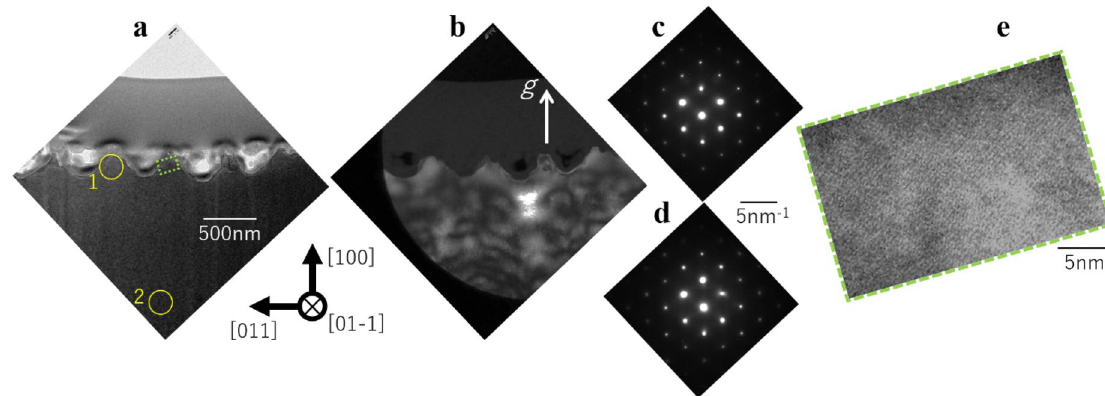
Figure 3. TEM images of the LIPSS induced by Ti:Sapphire laser. ( a ) Bright-field TEM image, ( b ) dark-field image, ( c ) diffraction pattern of area 1, ( d) diffraction pattern of area 2, ( e ) high-resolution image of the square- marled area in figure ( a